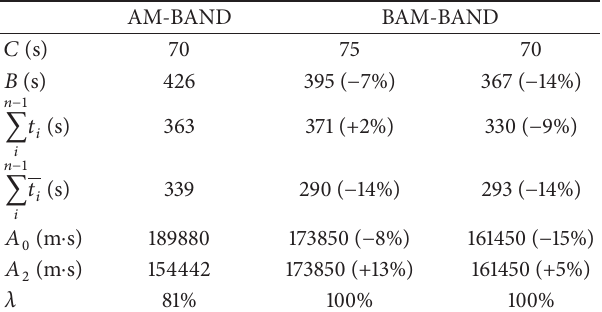
Table 2: Results contrast of AM-BAND and